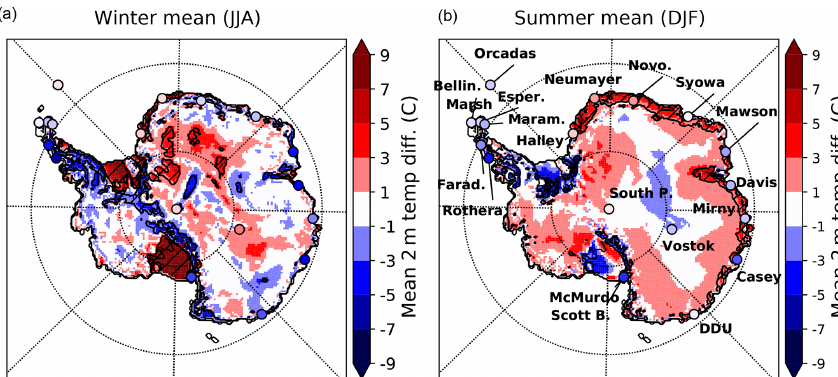
Figure 4. T 2m differences between ARP-AMIP and MAR–ERA-I (Agosta et al., 2018) simulations in winter (JJA, a ) and summer (DJF, b ) for the reference period 1981–2010. Circles are T 2m differences between ARP-AMIP and weather stations from the READER database, station names are shown in (b) (Bellin.: Bellingshausen; DDU: Dumont D’Urville; Esper.: Esperanza; Farad.: Faraday; Maram.: